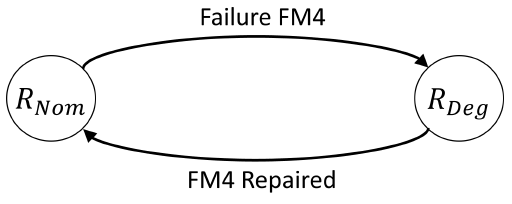
Figure 13. Behavioral modes of the Agent